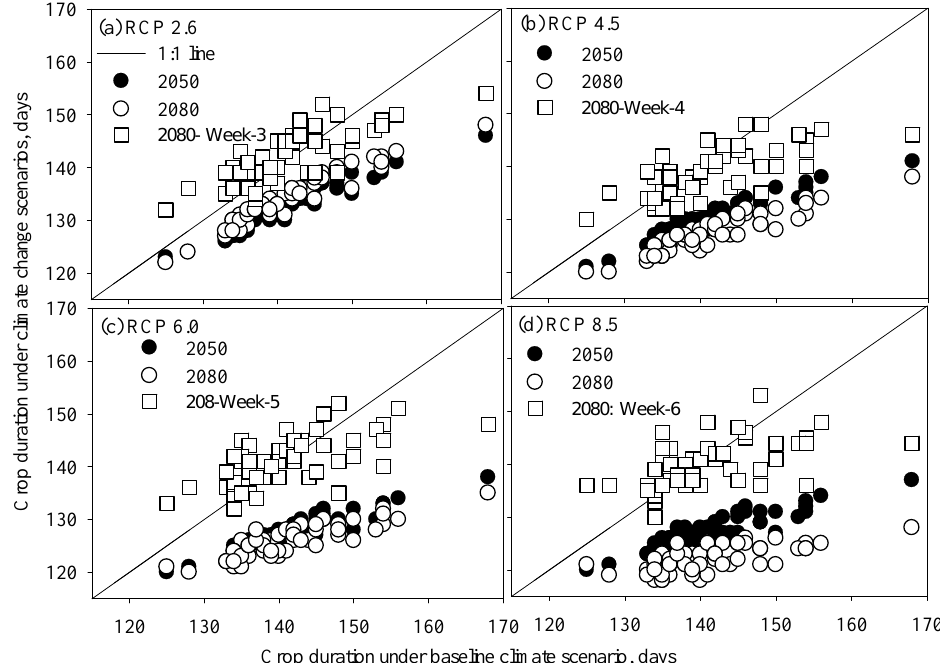
Figure 8. Comparison between the simulated crop durations in baseline climate and crop durations under climate change (CC) in 2050 and 2080 under RCPs of 2.6 ( a ), 4.5 ( b ), 6.0 ( c ), and 8.5 ( d ) for normal date of planting (2 May). Also, shown are the crop durations for earlier than normal plantings of three weeks (week-3) under RCP 2.5, four weeks (week-4) under RCP 4.5, five weeks (week-5) under RCP 6.0, and six weeks (week-6) under RCP 8.5 driven climate changes in 2080.